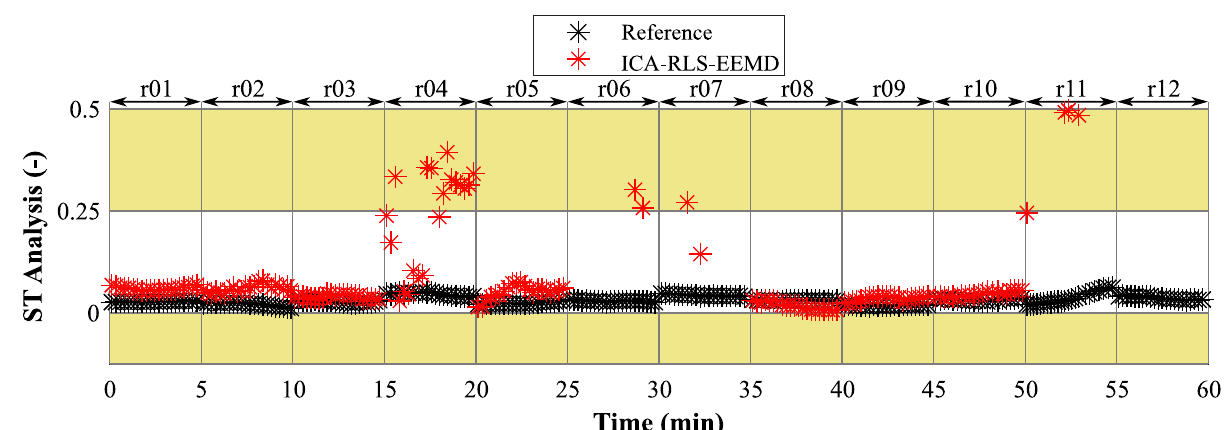
Fig 11. Comparison of estimated and reference T/QRS ratios of averaged fECG complexes over time.